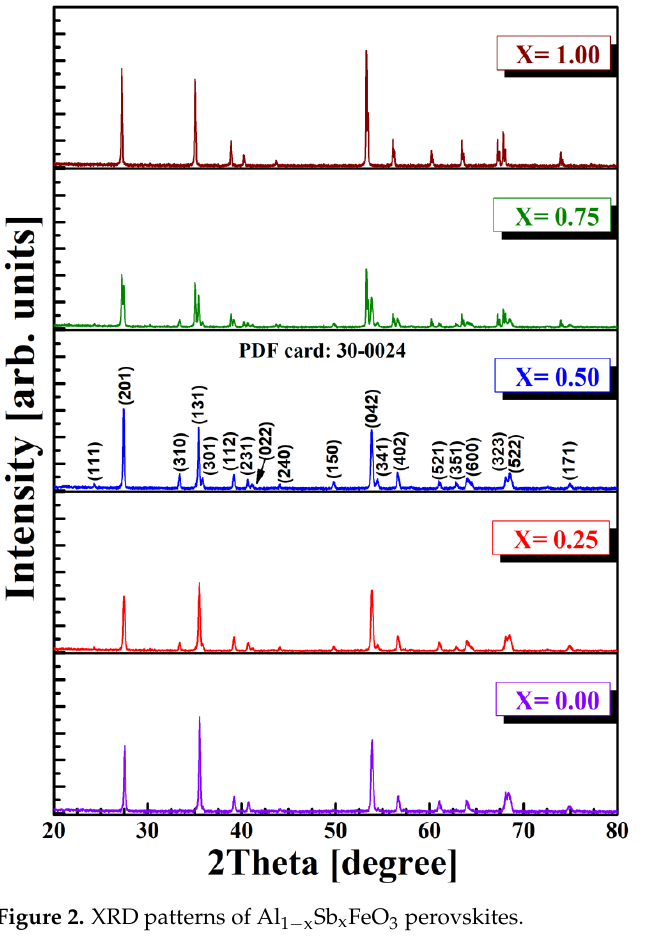
Figure 2. XRD patterns of Al 1 − x Sb x FeO 3 perovskites.